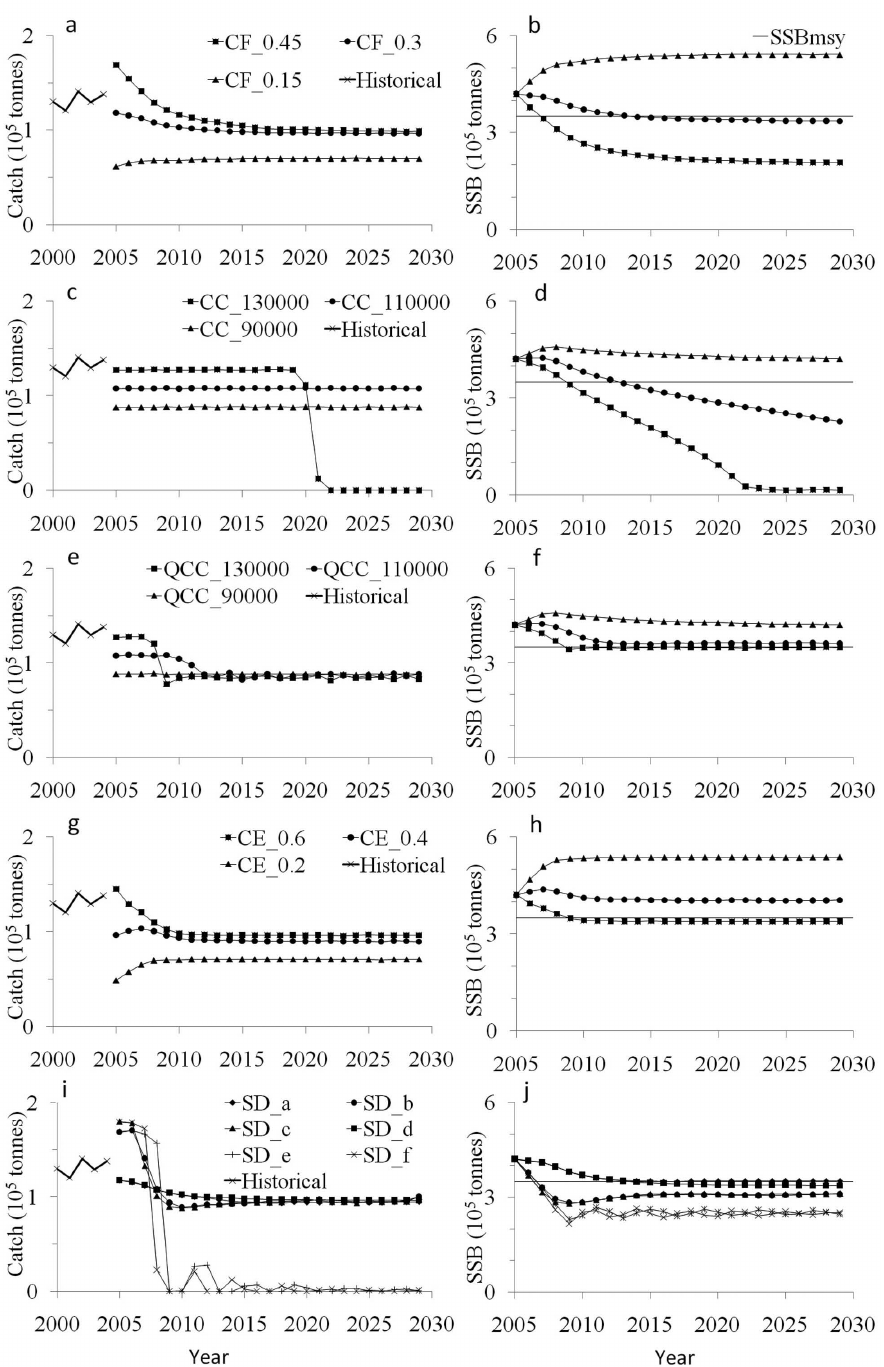
Fig . 4. – Temporal trajectories of mean catch and SSB under different management strategies (CF, constant fishing mortality; CC, constant catch; QCC, quasi-constant catch; CE, constant escapement; SD, status-dependent harvest